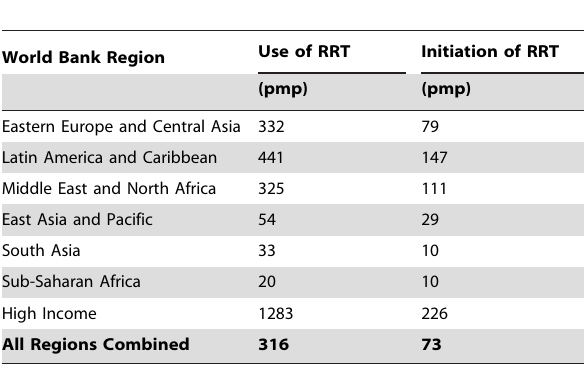
Table 1. Use and annual initiation of renal replacement